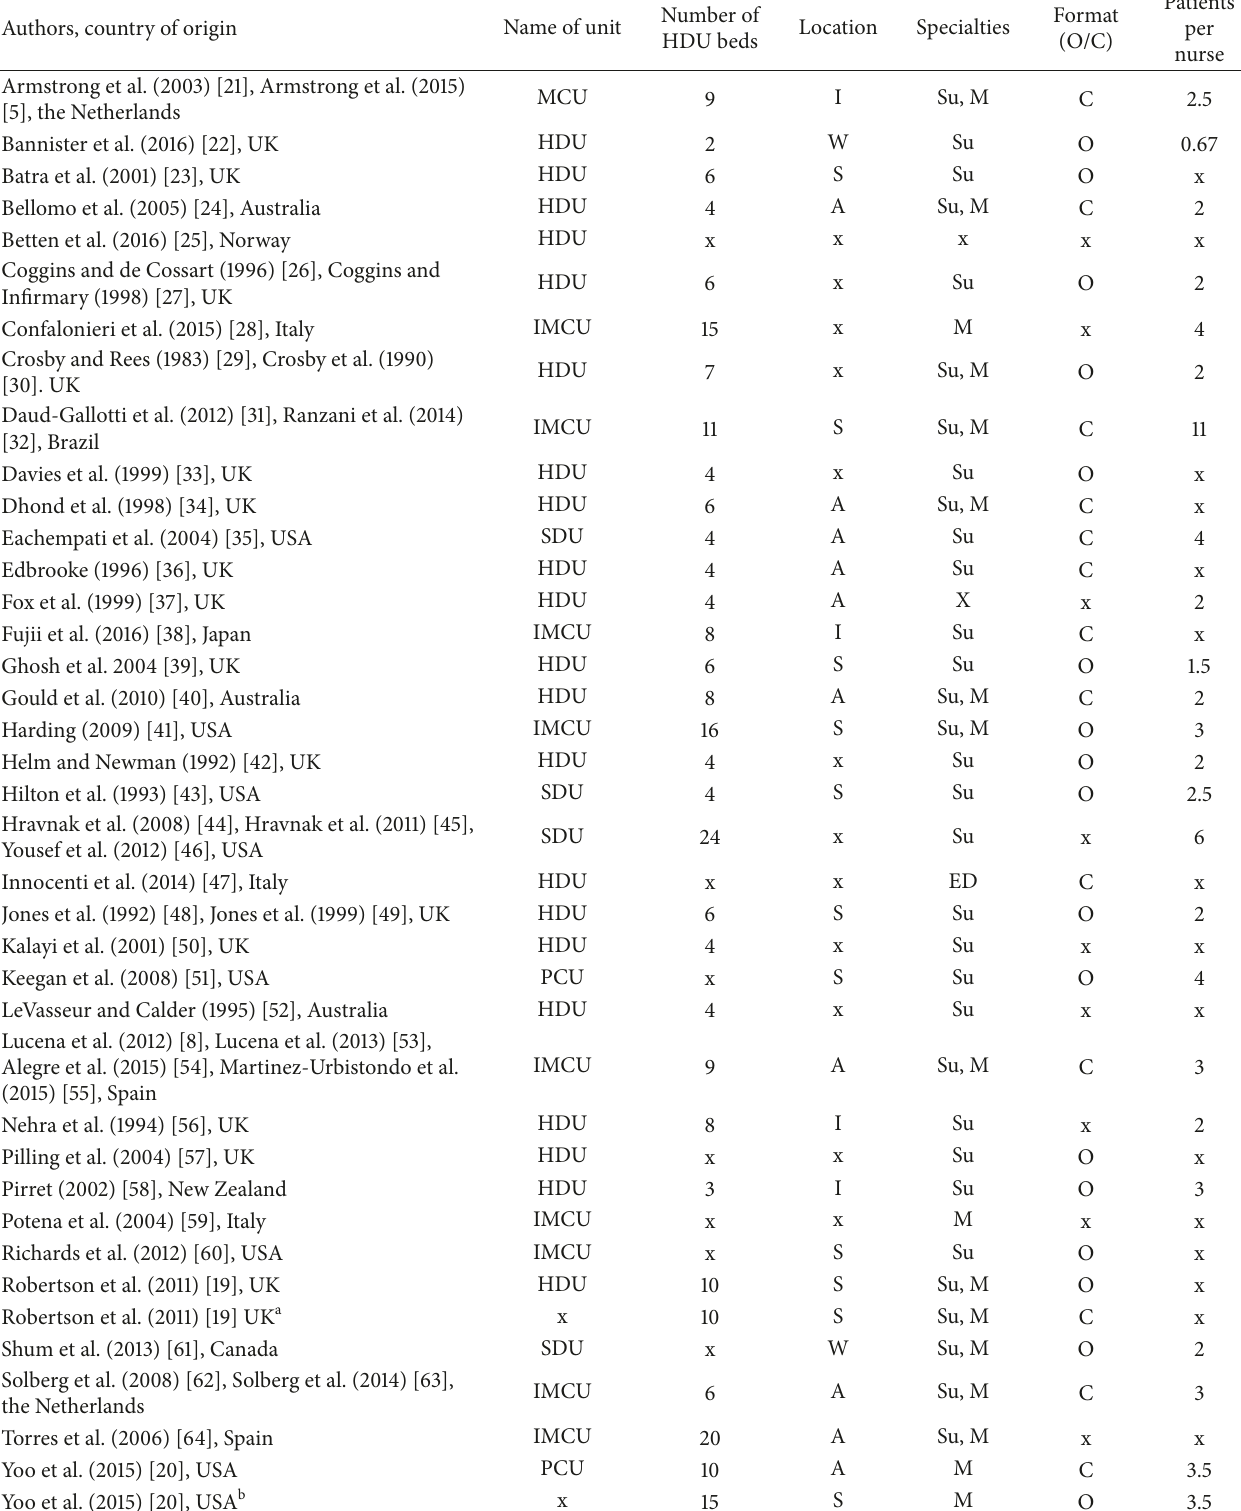
Table 1: Summary of study characteristics of intermediate care